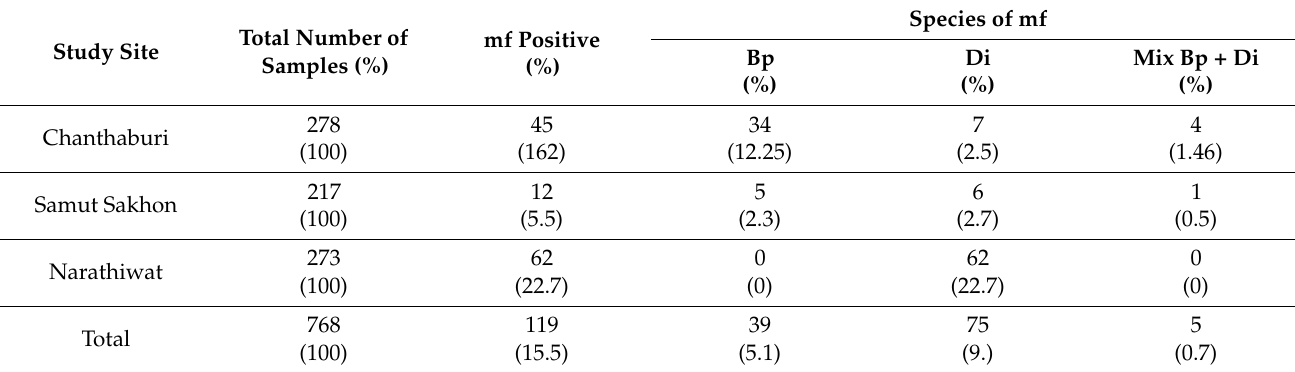
Table 1. Data of microfilariae positive (%) samples detected from 768 dogs stay in Chanthaburi, Samut Sakhon, and Narathiwat provinces, Thailand. Bp = B. pahangi , Di = D. immitis , Mix Bp + Di = mix infection with B. pahangi and D. immitis , mf = microfilaria.